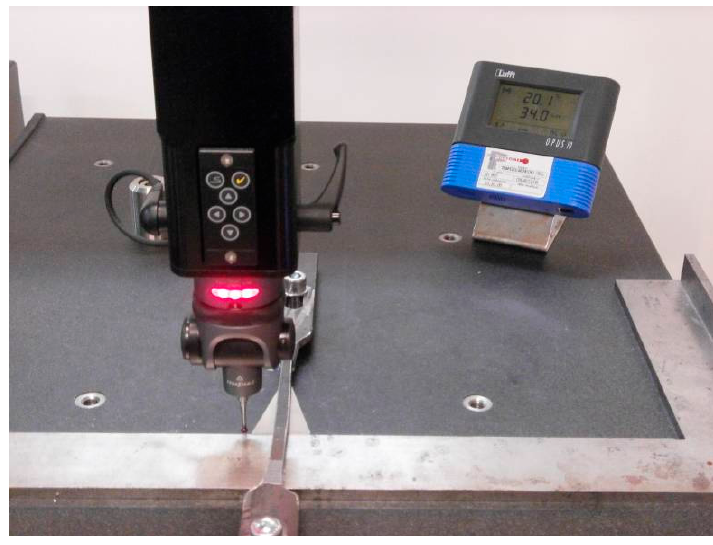
Figure 7. Angle gauge block measuring. Table 3. Angle block measurement results. CASE 4. Angle gauge block 45° ± 2 ′′ . Data Table A2.